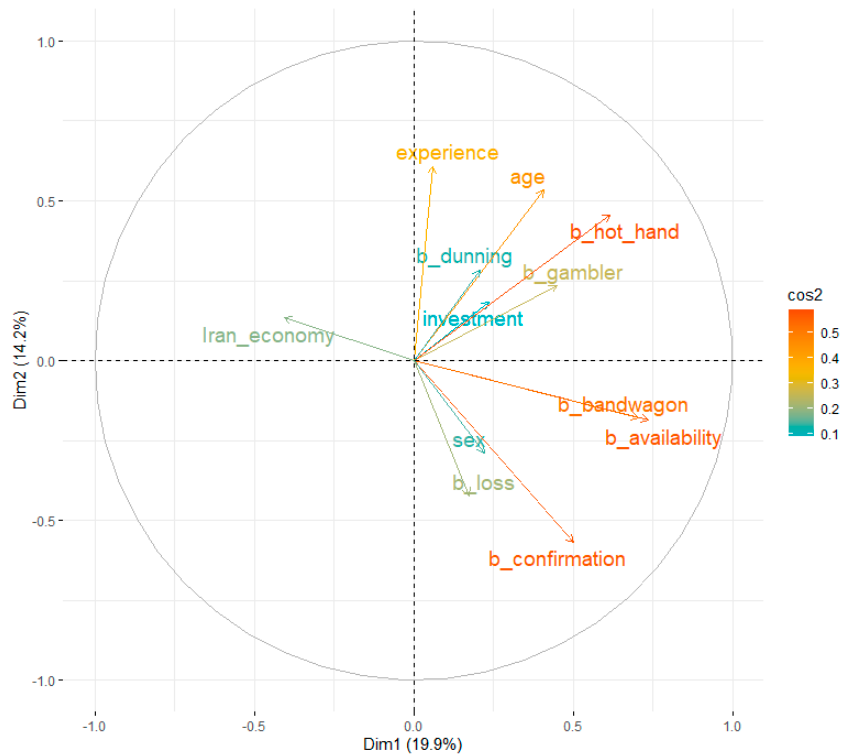
Figure 4. Quality and direction of representation for variables.